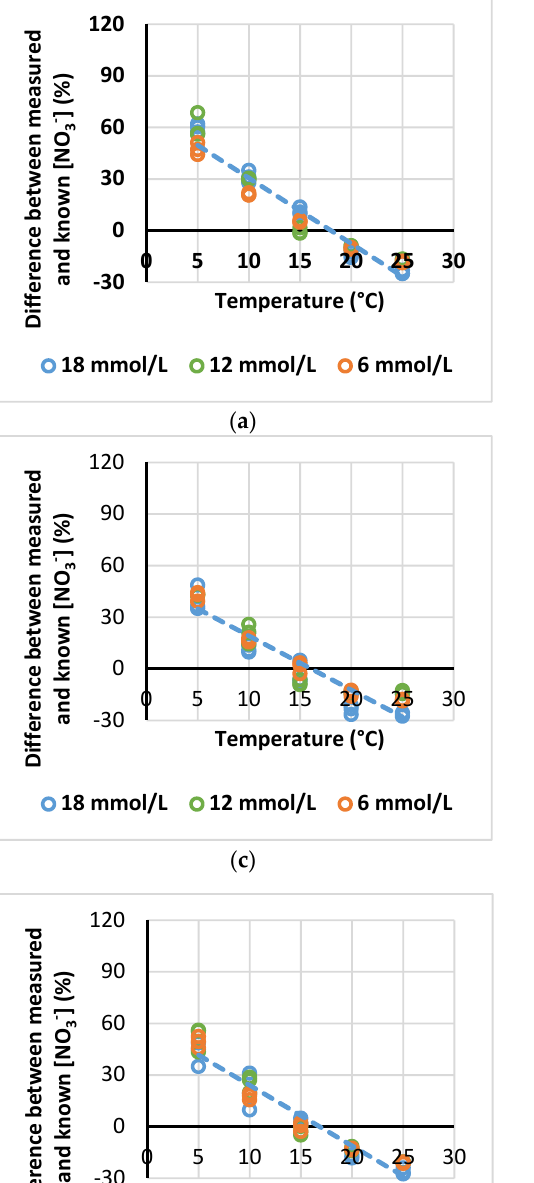
For the pooled data set, that combined all data for each of the six combinations of ISE meter and NO 3 − source, the linear regression y = − 3.68x + 68.1, with R 2 = 0.88, described the data (Table 1). The intercept value with the x-axis, signifying zero relative error, was 18.5 °C for the pooled data (Table 1). Applying this linear regression to the sample tempera- tures used in the study, indicated that the average temperature-induced errors in this study were +49.7, +31.3, +12.9, − 5.5, and − 23.9% for sample temperatures of 5, 10, 15, 20 and 25 °C, respectively (Table 2).